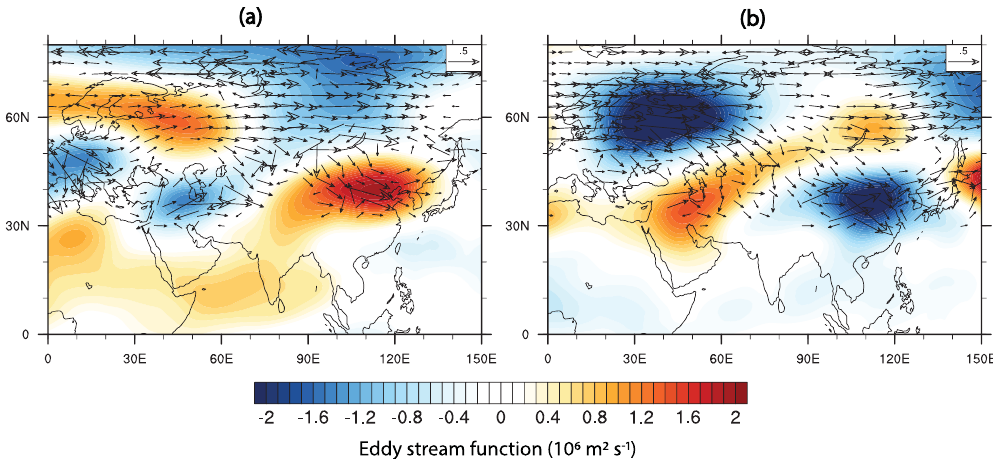
Fig. 3 Pathways of large-scale circulation anomaly propagation during ISMR extremes. Eddy stream functions (shades, 10 6 m 2 s − 1 ) and Rossby wave activity fl ux (contours, m 2 s − 2 ) as in Takaya and Nakamura (2001) 27 during August – September averaged for years with ( a ) increased (P1: 1992 – 1997 and P2: 2004 – 2010) and ( b ) reduced (N1: 1986 – 1991 and N2: 1998 – 2003) extreme rainfall in September over central India. Vectors with magnitude >0.1 m 2 s − 2 are shown for